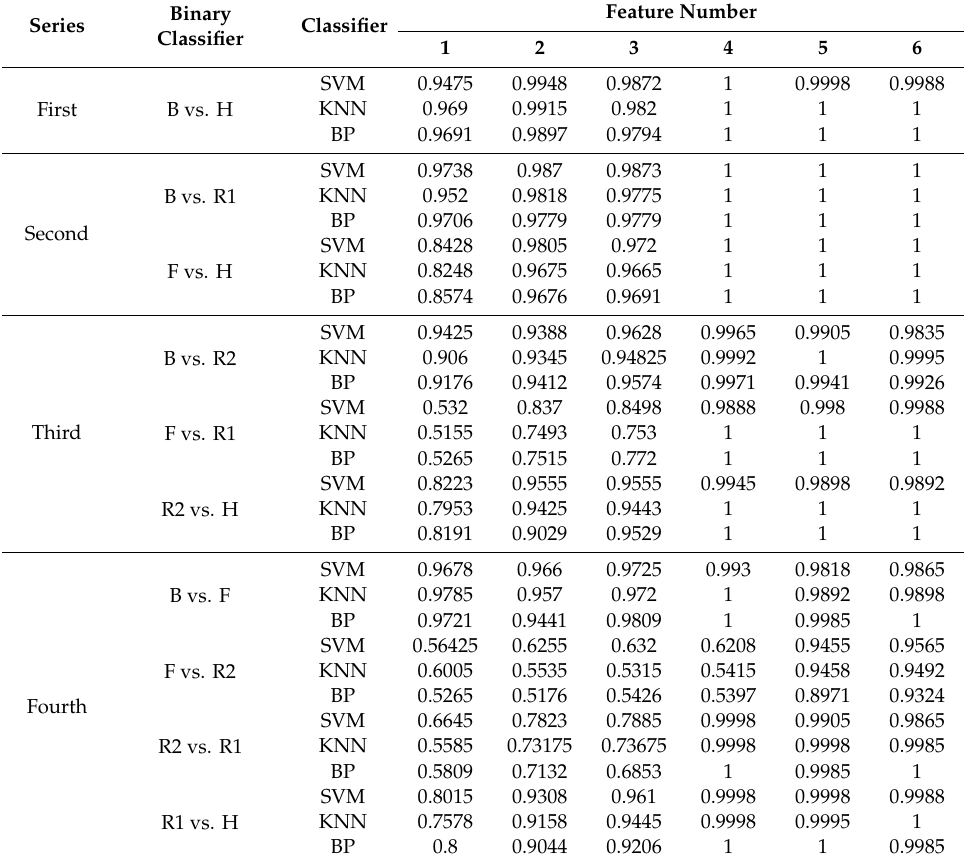
Table A1. The classification accuracy rates of each binary classifier from one feature to six